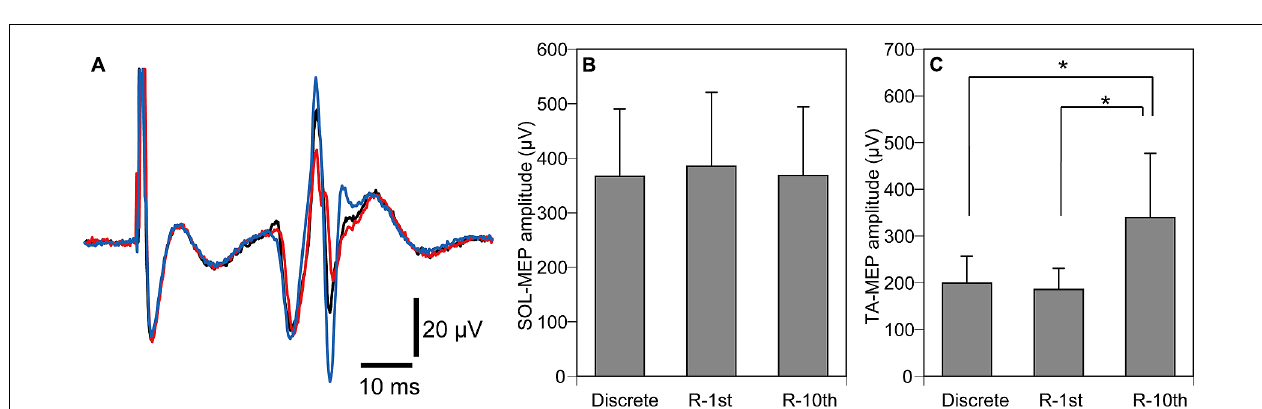
under the R-10th condition (A) . Note that MEP under the R-10th condition is larger than the other two experimental conditions. Bars indicate mean and error bars indicate standard error of mean (B,C) . Asterisks indicate significant difference ( P <